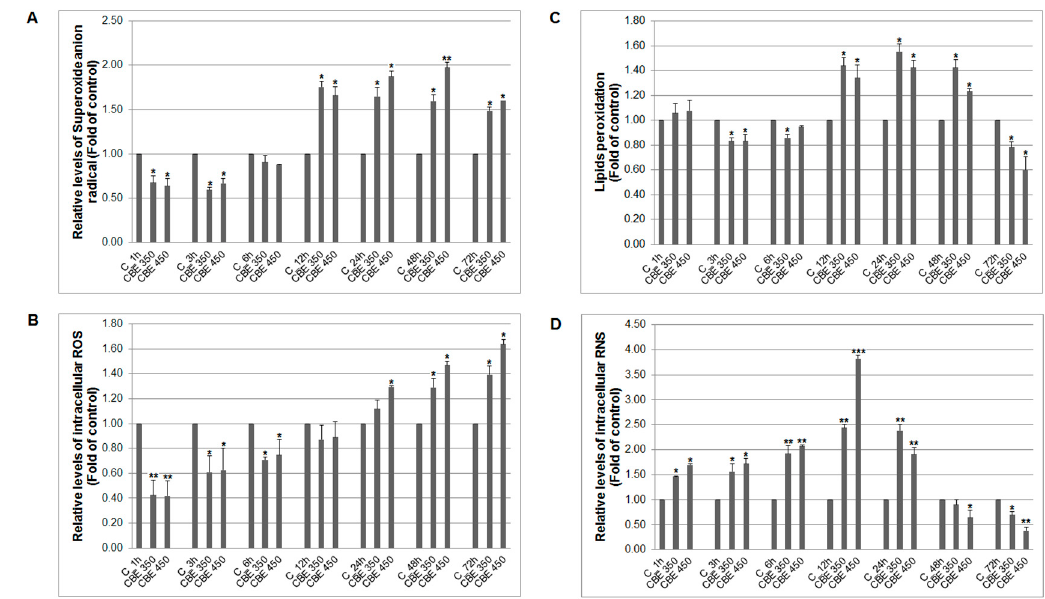
Figure 3. Effect of CBE on relative levels of ( A ) superoxide anions, ( B ) intracellular ROS, ( C ) lipids peroxides and ( D ) intracellular RNS in MCF-7 cells. Data were obtained from three independent flow cytometry experiments after 1–72 h CBE treatment. Significance: * p < 0.05, ** p < 0.01, *** p < 0.001 vs. untreated cells (control).